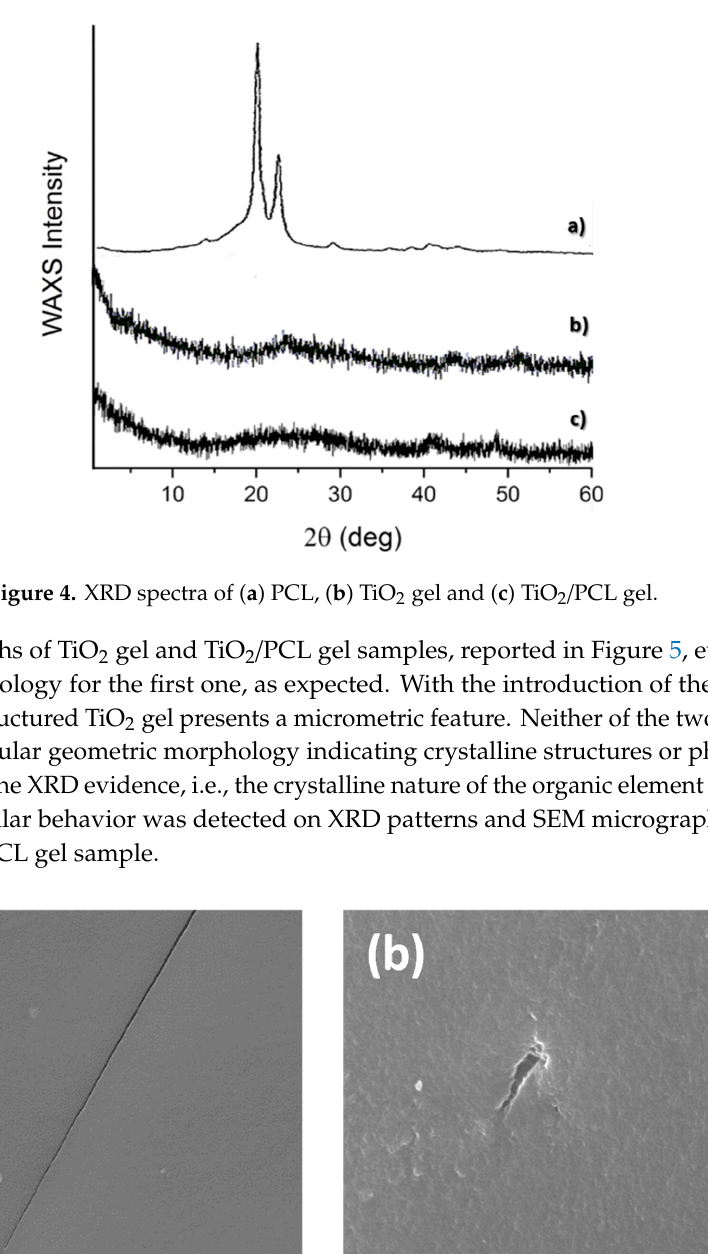
Figure 5. Scanning electron microscopy (SEM) micrograph of ( a ) TiO 2 gel and ( b ) TiO 2 /PCL 6 wt.% gel.